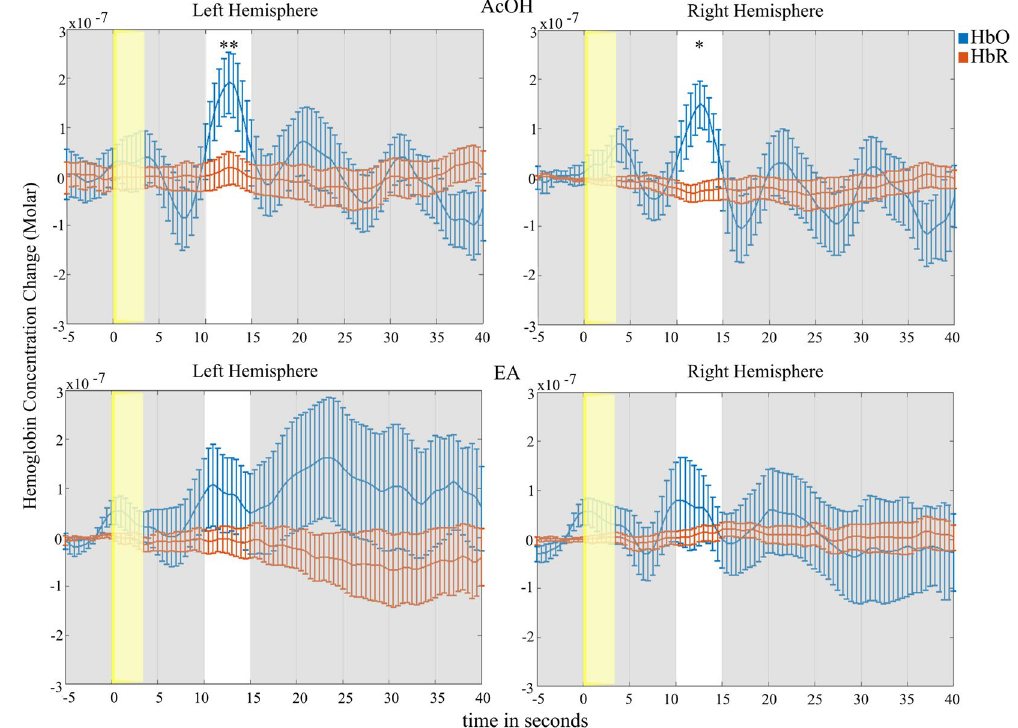
Figure 2. Hemodynamic response in averaged channels after birhinal AcOH (top) and EA (bottom) stimulation. Left images represent the left hemisphere and vice versa. The yellow bar indicates stimulus presentation whereas the white time window (10–15 s) marks the time interval of interest. Error bars correspond to + / − SEM . * p < 0.05, ** p < 0.01; HbO vs baseline.